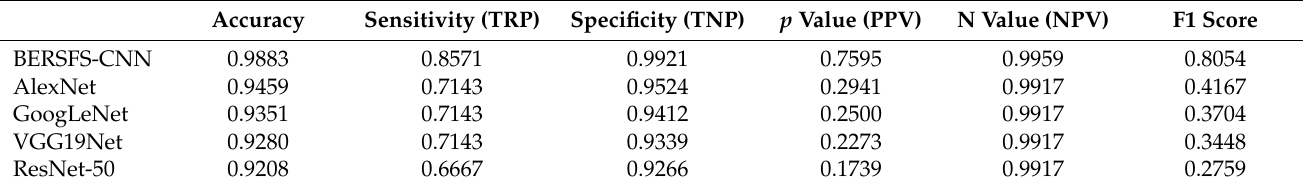
Table 7. Results of comparisons between proposed BERSFS-CNN and deep learning